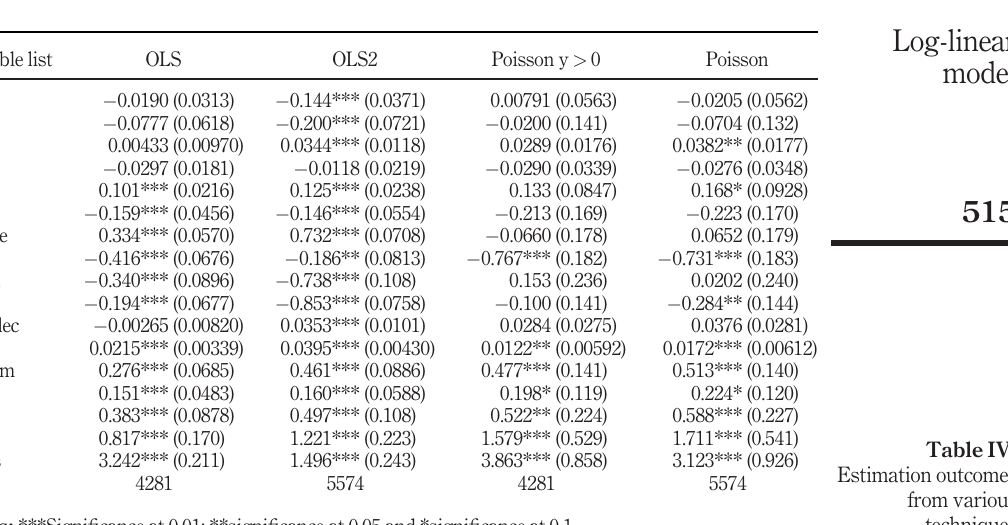
Table IV. Estimation